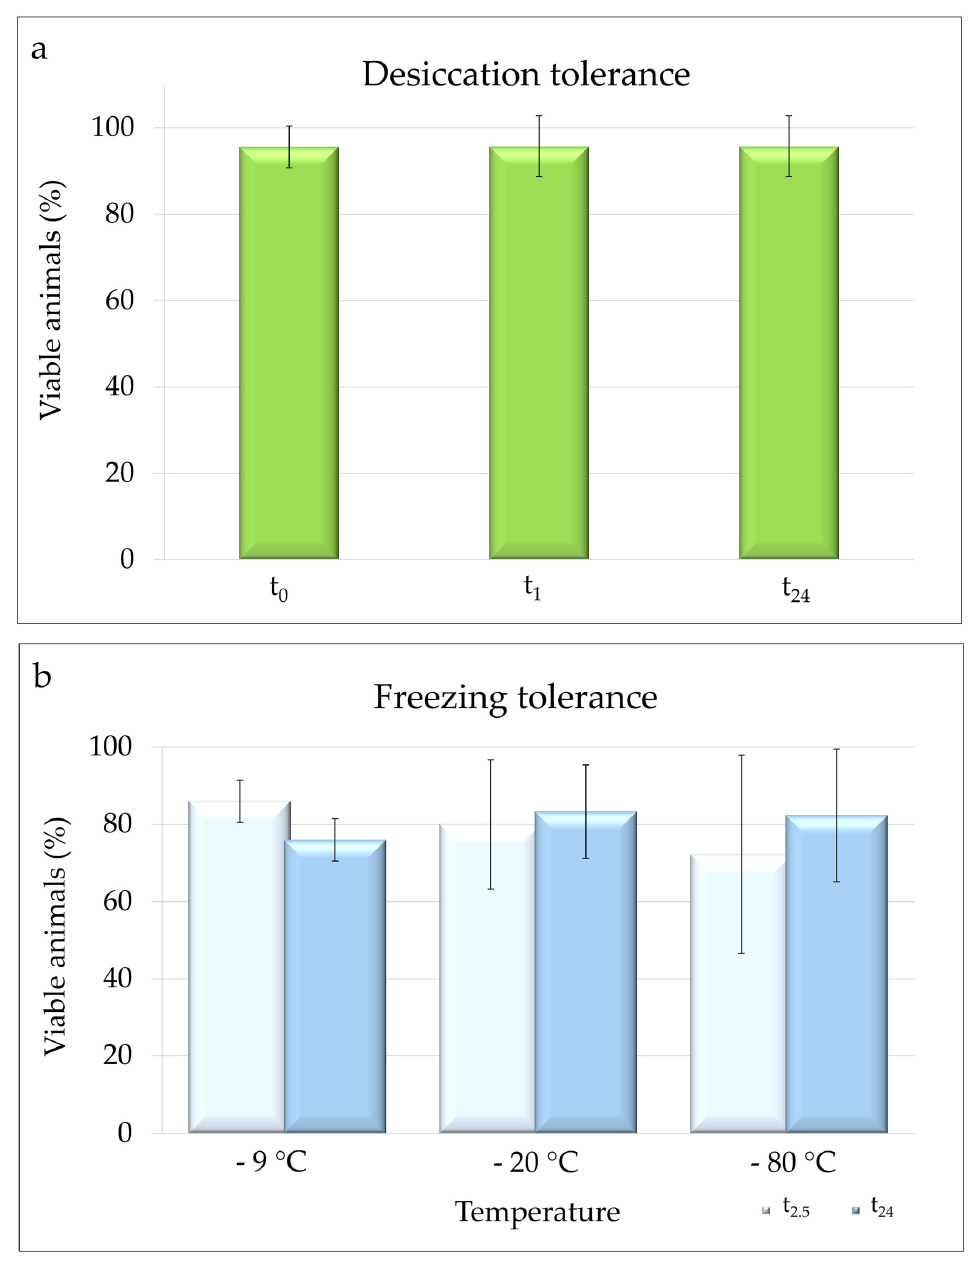
Figure 7. Desiccation and freezing tolerance of M. kyoukenus sp. nov. ( a ) Percentage of viable animals immediately after rehydration (t 0 ), after 1 h (t 1 ) and 24 h (t 24 ; final survival); ( b ) Percentage of viable animals at 2.5 h (t 2.5 ) post thawing and after 24 h (t 24 ; final survival) at different freezing temperature ( − 9, − 20 and − 80 ◦ C). Each column represents the mean value of six replicates and the bar on each column represents the standard